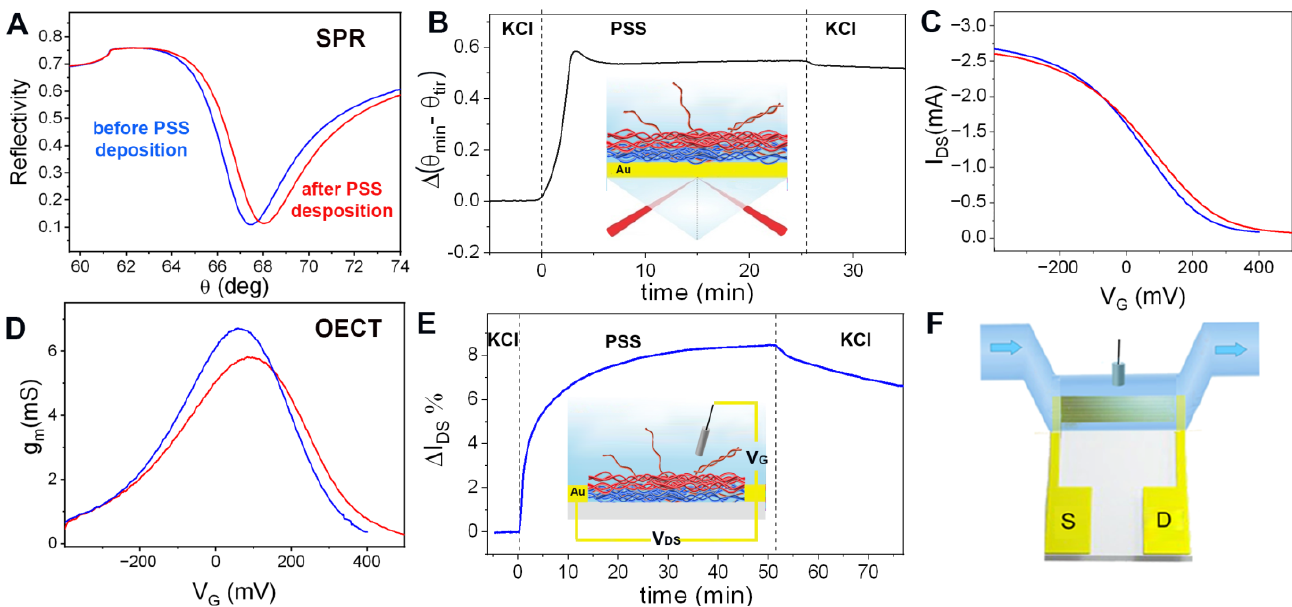
Figure 3. ( A ) Reflectivity curves of the PEDOT-PAH substrate before (blue) and after (red) PSS deposition. ( B ) Real-time change in the SPR signal ∆ ( θ min – θ tir ) during the deposition of PSS on a gold substrate modified with PEDOT-PAH under flow conditions. ( C ) Transfer curves and ( D ) transconductance values of a PEDOT-PAH OECT in 0.1 M KCl before (blue) and after (red) PSS deposition ( E ) Real time change in the OECT ΔI DS % current during PSS adsorption. ( F ) Scheme of the flow cell employed for the electrochemical measurements.